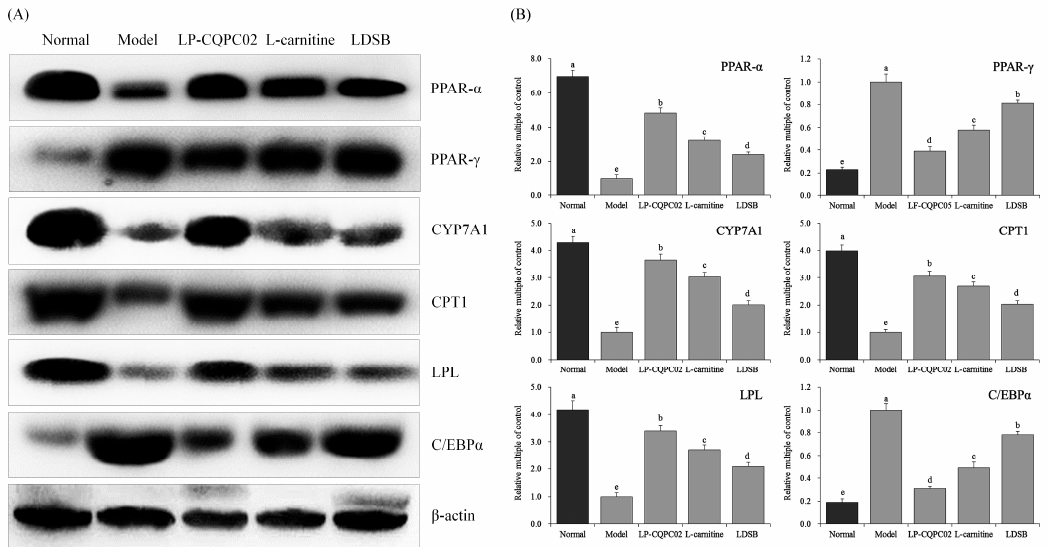
Figure 4. The peroxisome proliferator-activated receptor-alpha (PPAR- α ), peroxisome proliferator-activated receptor-gamma (PPAR- γ ), cholesterol 7 alpha-hydroxylase (CYP7A1), carnitine palmitoyltransferase 1, lipoprotein lipase (LPL) and CCAAT enhancer-binding protein alpha (C / EBP- α ) mRNA ( A ) and protein ( B ) expression in hepatic tissue of mice. a–e Mean values with di ff erent letters above the bar are significantly di ff erent ( p < 0.05) according to Duncan’s multiple-range test. LDSB: Mice treated with 1.0 × 10 9 CFU / kg of Lactobacillus delbruechii subsp. bulgaricus ; LP-CQPC02: Mice treated with 1.0 × 10 9 CFU / kg of Lactobacillus plantarum CQPC02; l -carnitine: Mice treated with 200 mg / kg of l